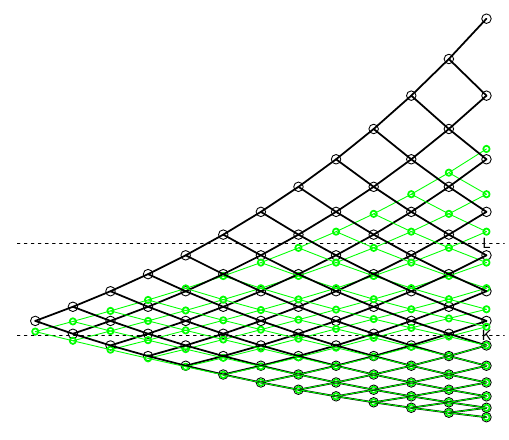
Figure 1. A tree of S ( t ) (black) and S W ( t )